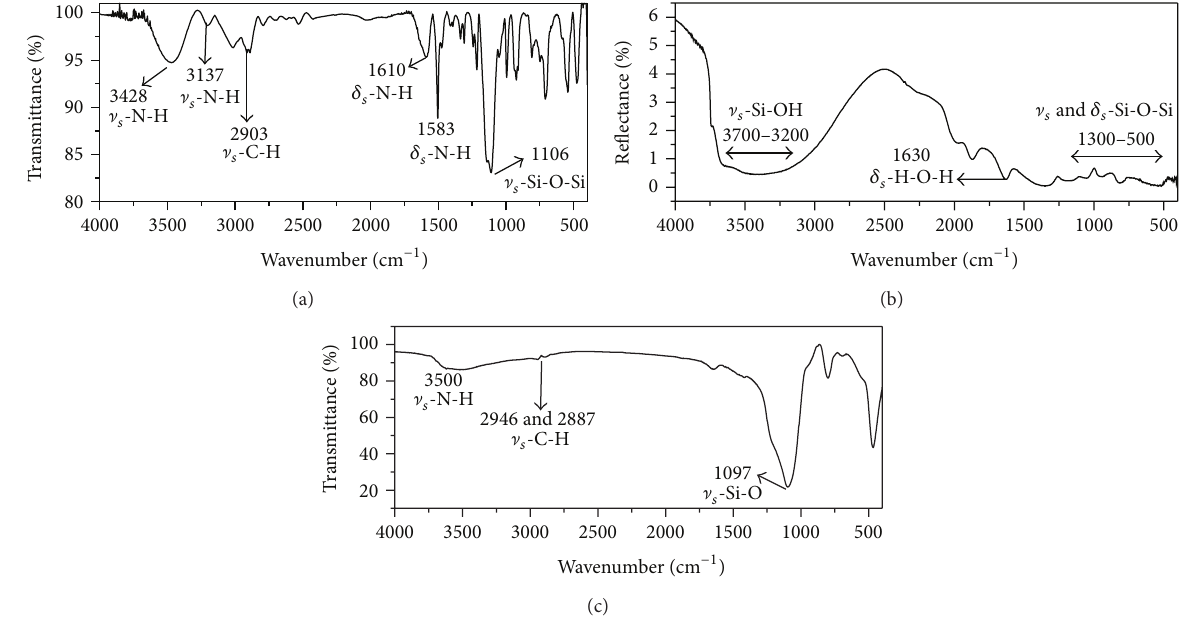
Figure 2: Vibrational spectrum for (a) APC; (b) SG; (c) SGAPC.